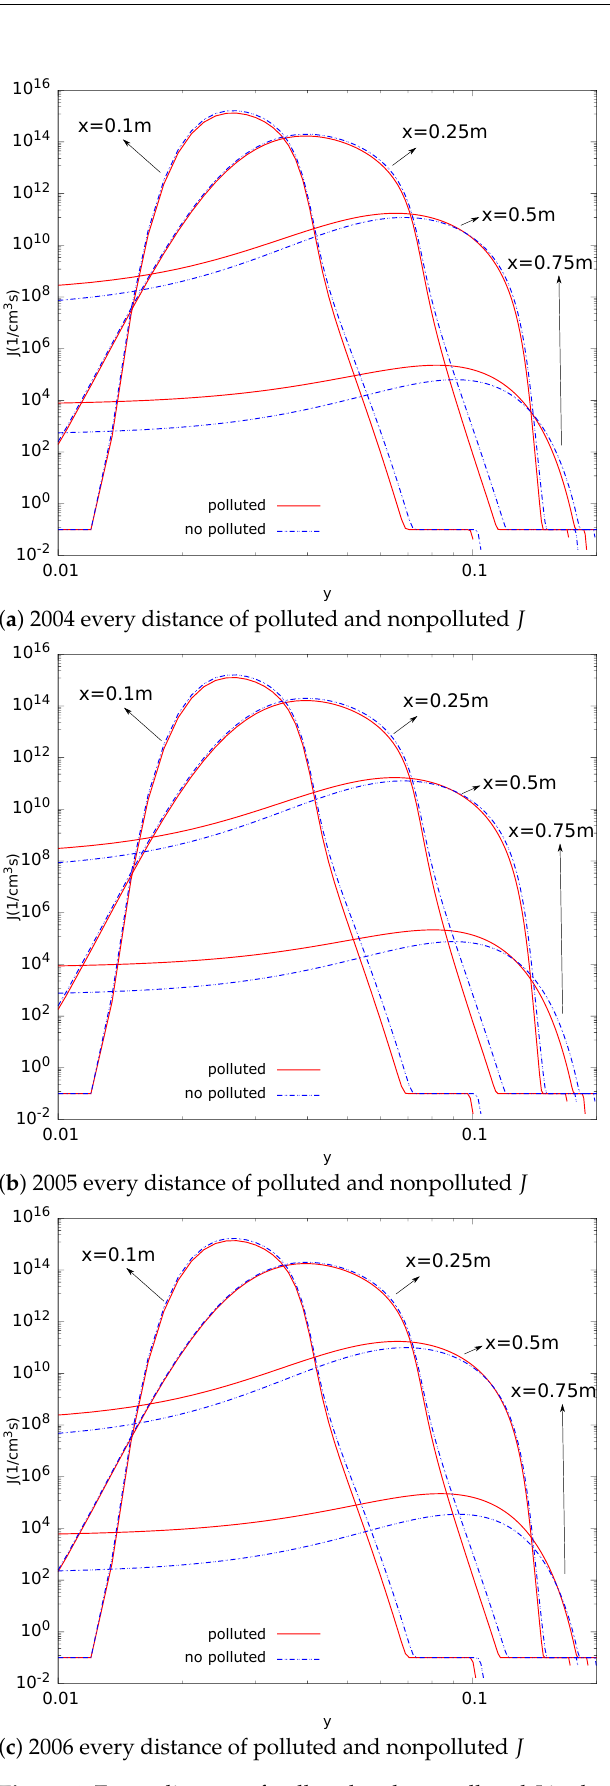
Figure 4. Every distance of polluted and nonpolluted J in three